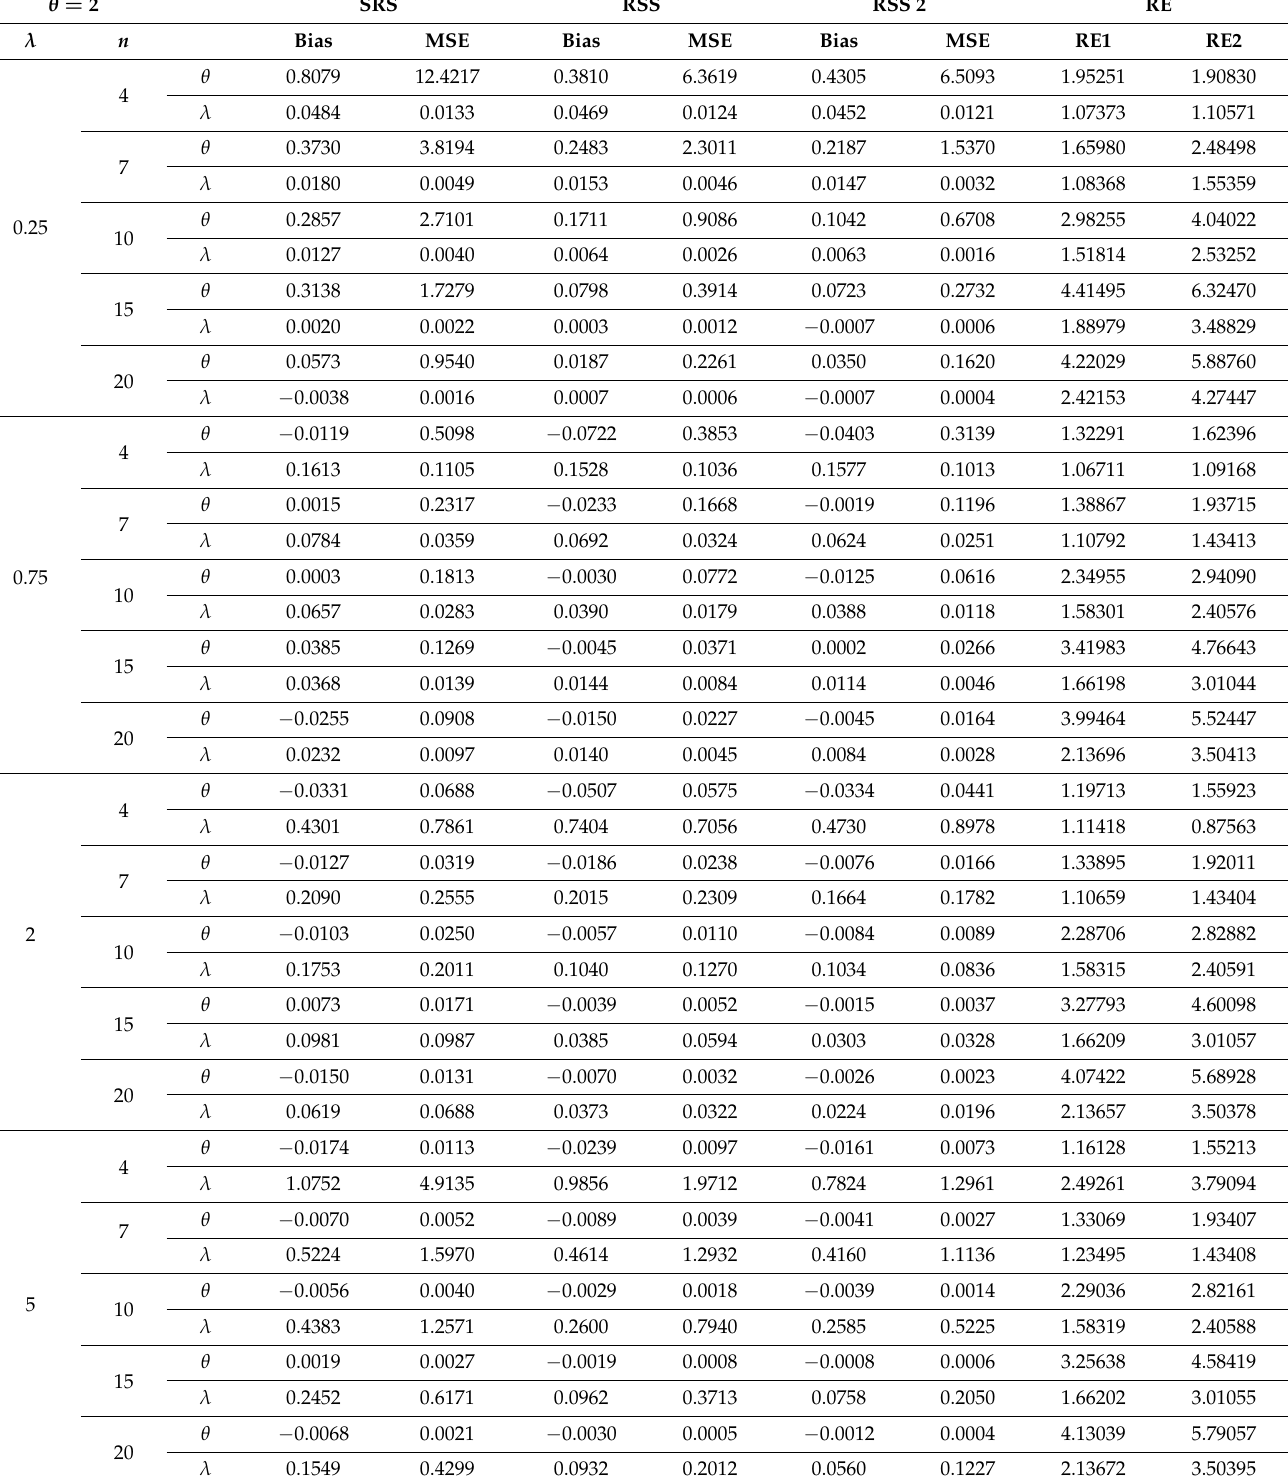
Table 5. Bias, MSE, and RE for the GB( θ , λ ) distribution under the SRS and RSS schemes when θ =